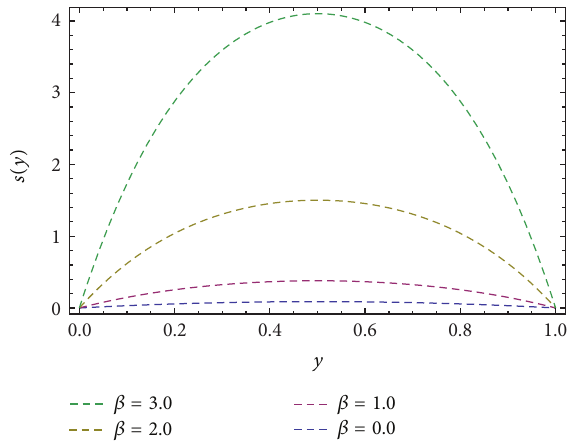
Figure 9: Velocity profile 𝑠(𝑦) for different values of 𝛽 , keeping 𝛼 = 1.0 , 𝜕𝑃/𝜕𝑥 = −0.5 , 𝜕𝑃/𝜕𝑧 = −0.5 , and 𝜙 = 45 ∘ .